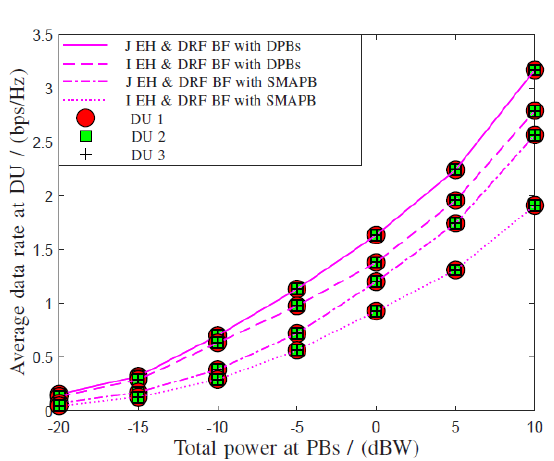
Figure 3. Comparison of data rates at DUs for the considered systems and beamforming techniques with the total power available at PBs. EH, energy harvesting; SMAPB, single multiple antenna